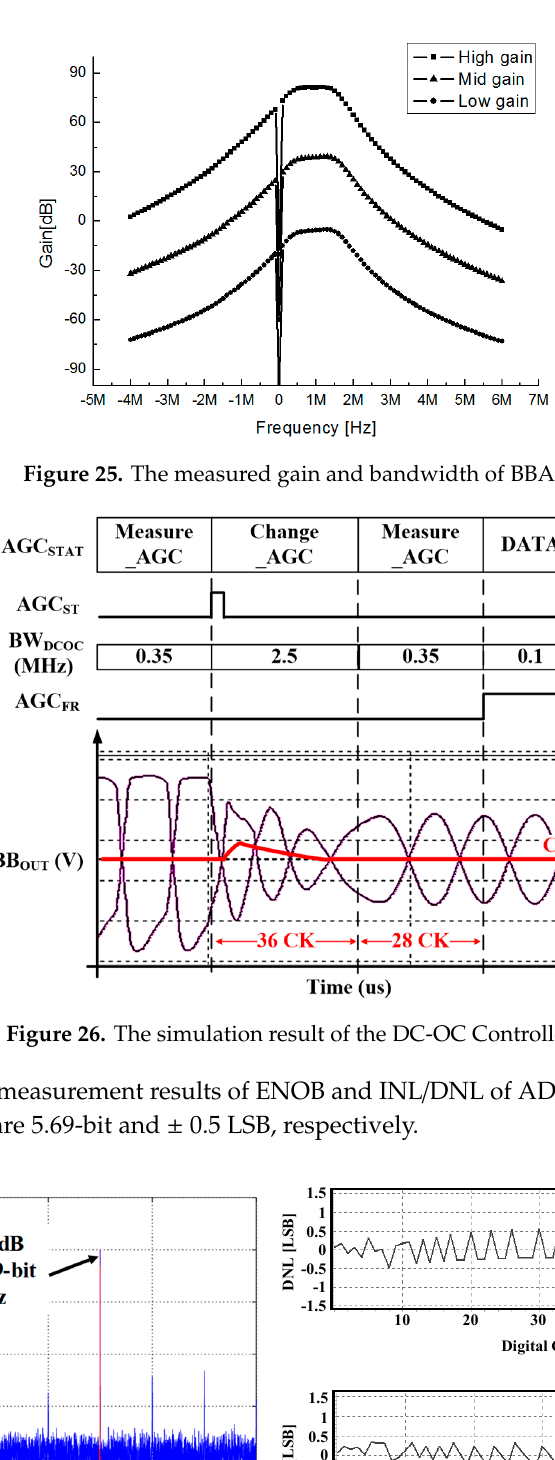
Figure 24. IIP3 and NF measurement results with respect to BLE channels.